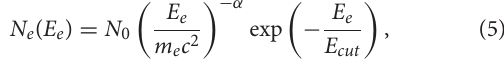
divided in two each (for a total of 12) to constrain the variability and make the fitting procedure